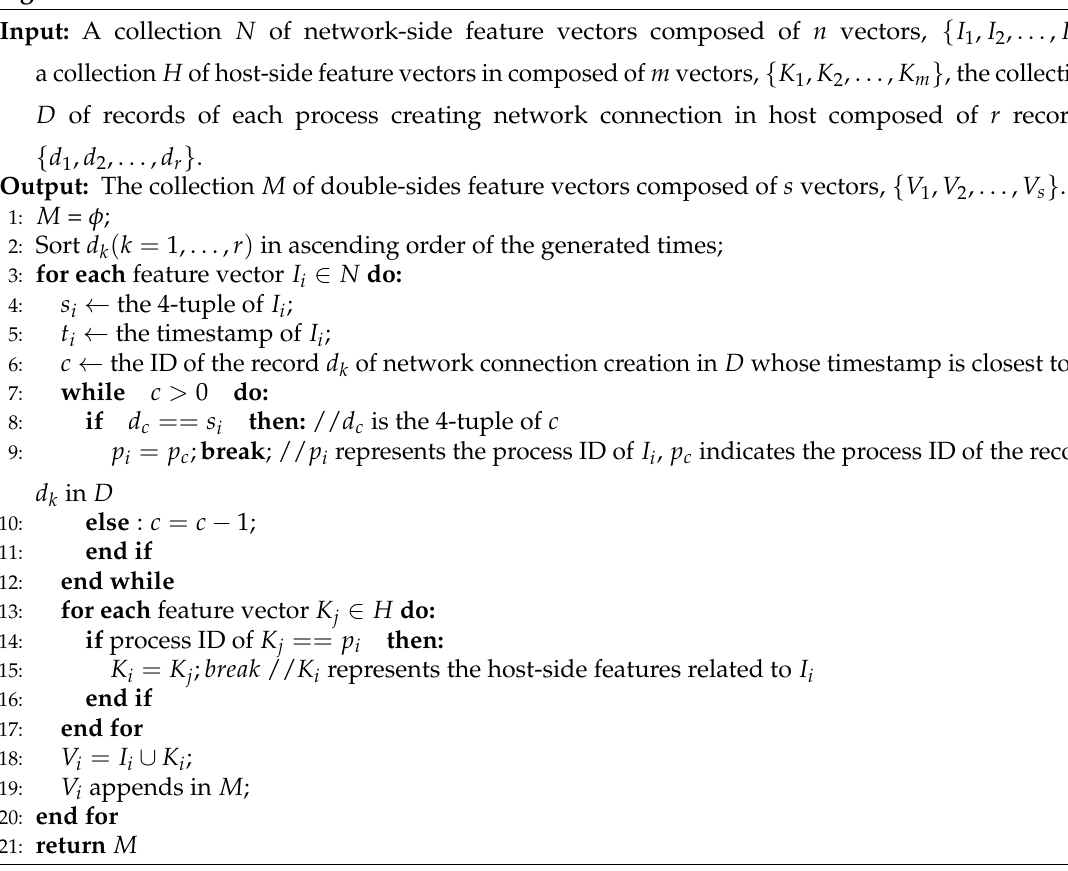
Algorithm 1 Double-sides features